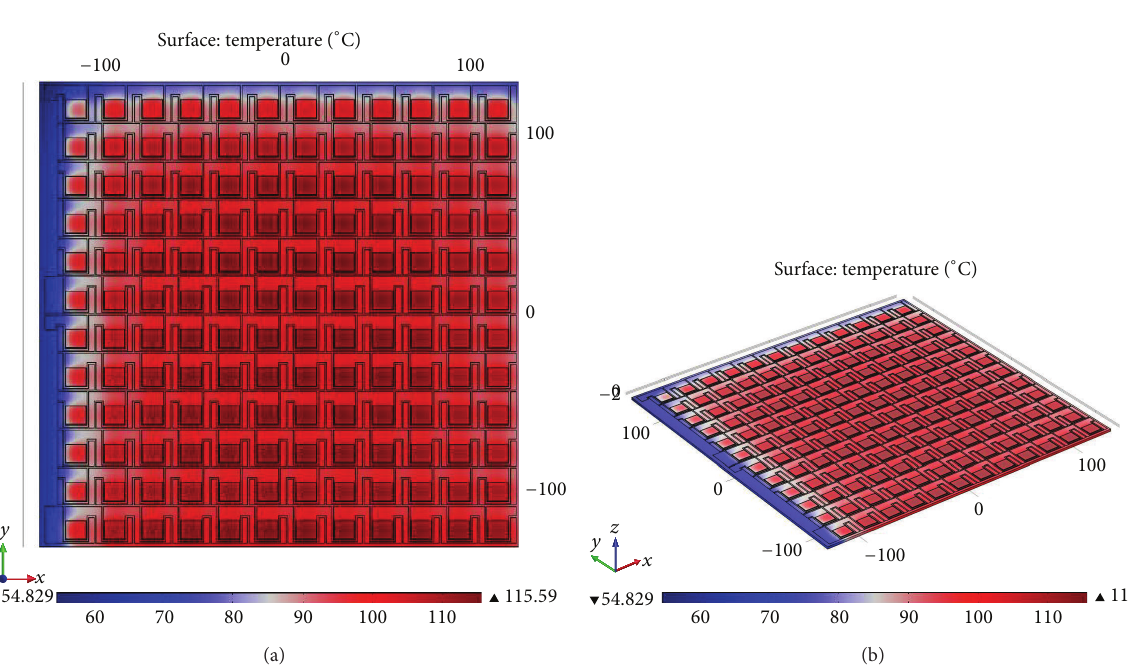
Figure 9: Front view (a) and lateral view (b) of the temperature distribution of the full scaled board in the worst case conditions in ∘ C. Max. cell’s temperature: 115.6 ∘ C. Min. cell’s temperature: 91.9 ∘ C.